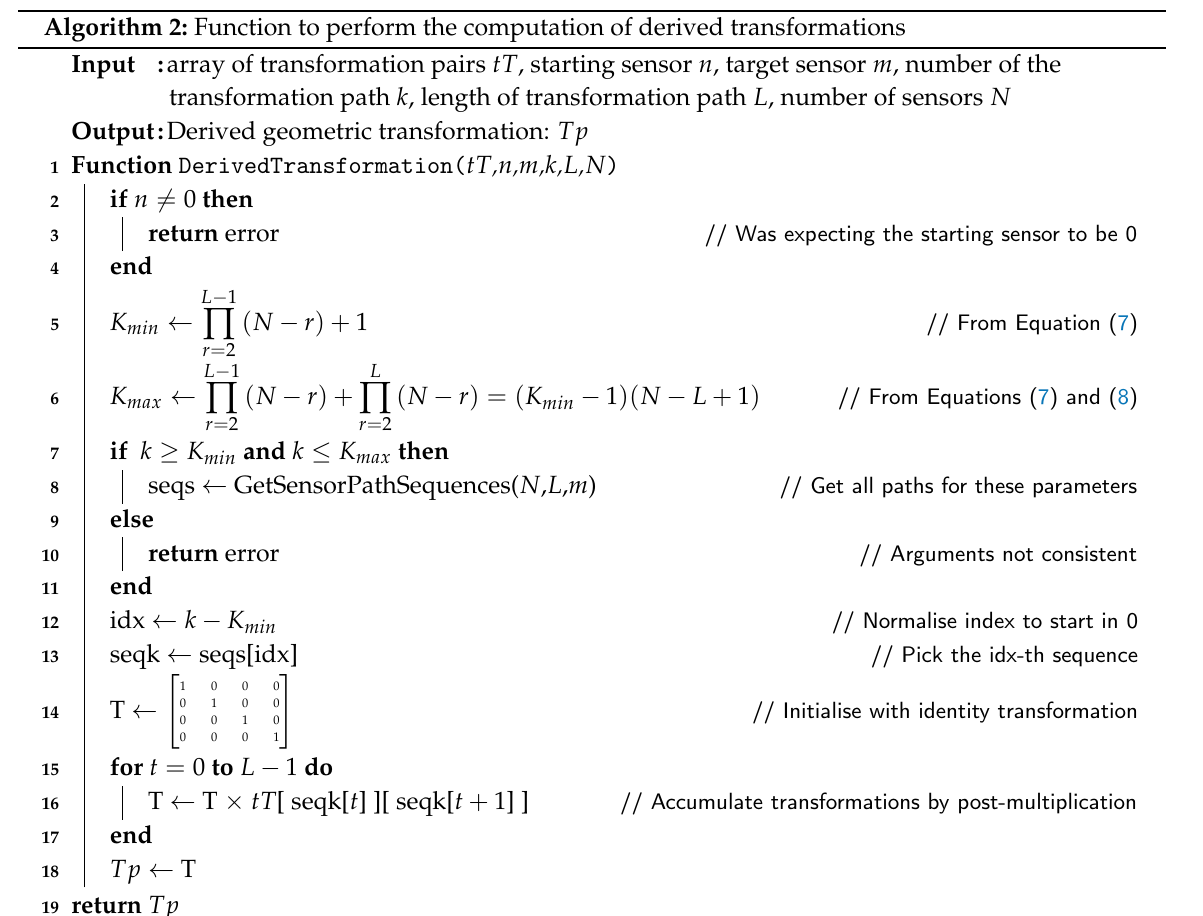
Algorithm 2: Function to perform the computation of derived transformations Input : array of transformation pairs tT , starting sensor n , target sensor m , number of the